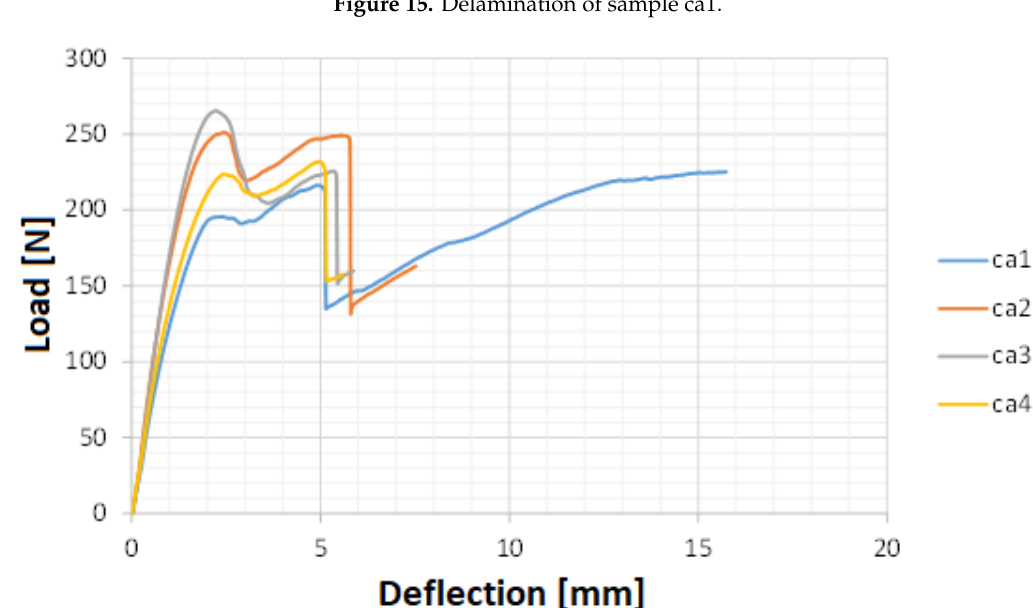
Figure 16. Load vs. mid-span deflection measured during testing of sandwich 2 samples.